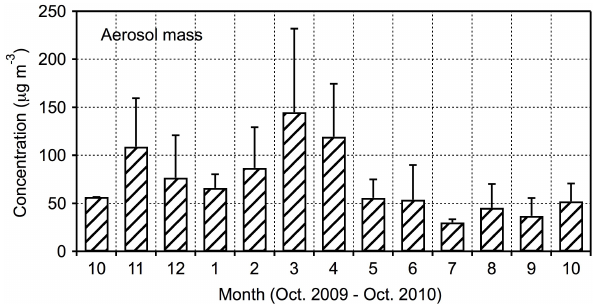
Fig. 3. Average monthly variation of aerosol mass loading in ambi- ent aerosols collected in Cape Hedo, Okinawa.